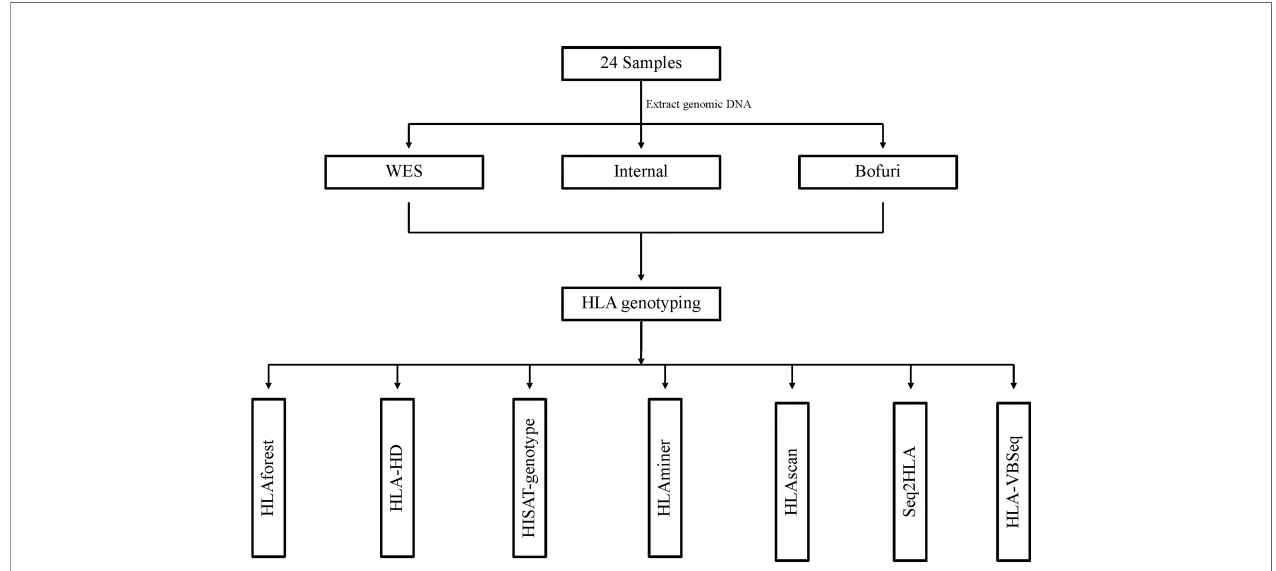
FIGURE 1 | Work fl ow of HLA typing using benchmarked data sets. All HLA typing algorithms were run with default